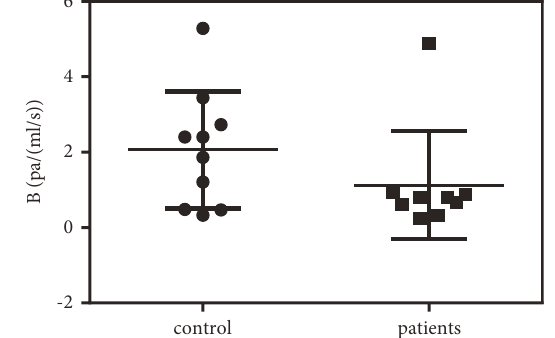
Figure 4: Flow resistance analysis of SV.